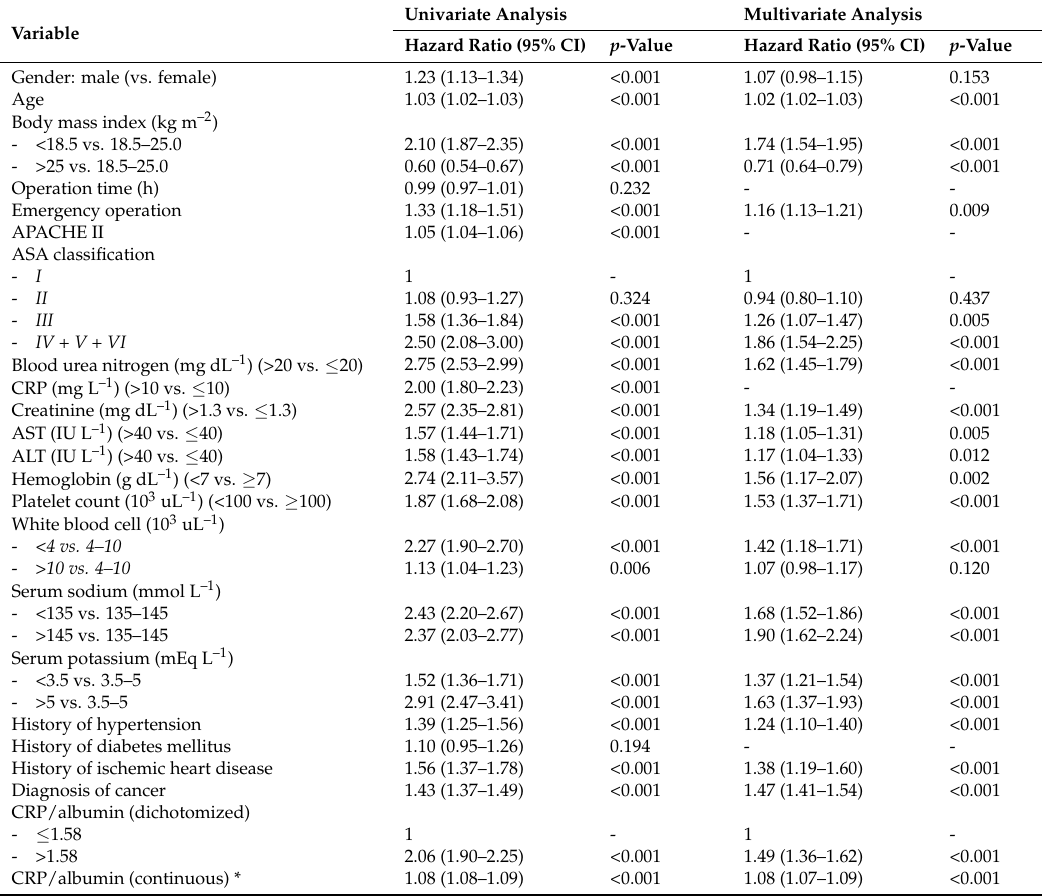
Table 3. Univariate and multivariate Cox regression analysis in relation to 1-year mortality after postoperative ICU